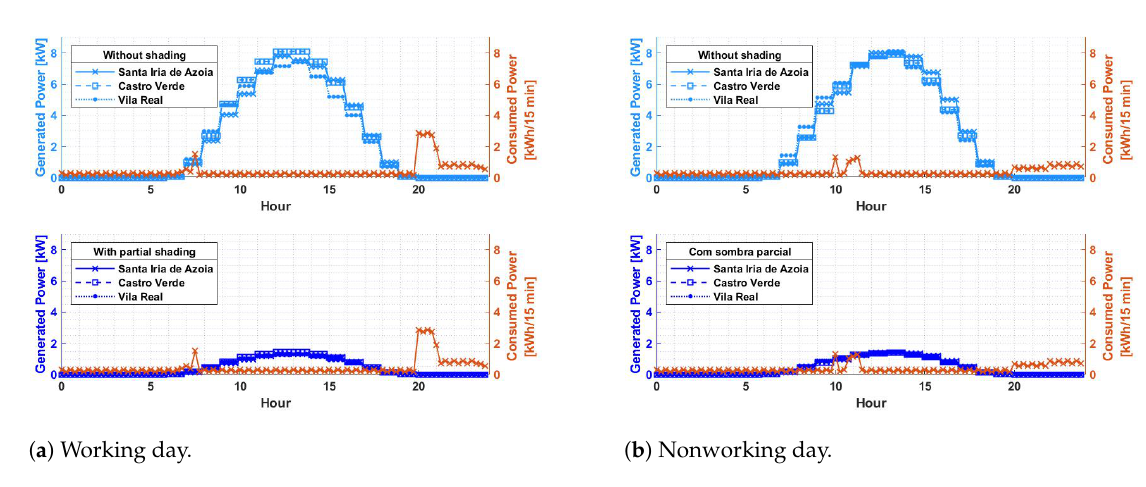
Figure 8. Generation and consumption curves on the two significant days of August for c-Si NWs technology.